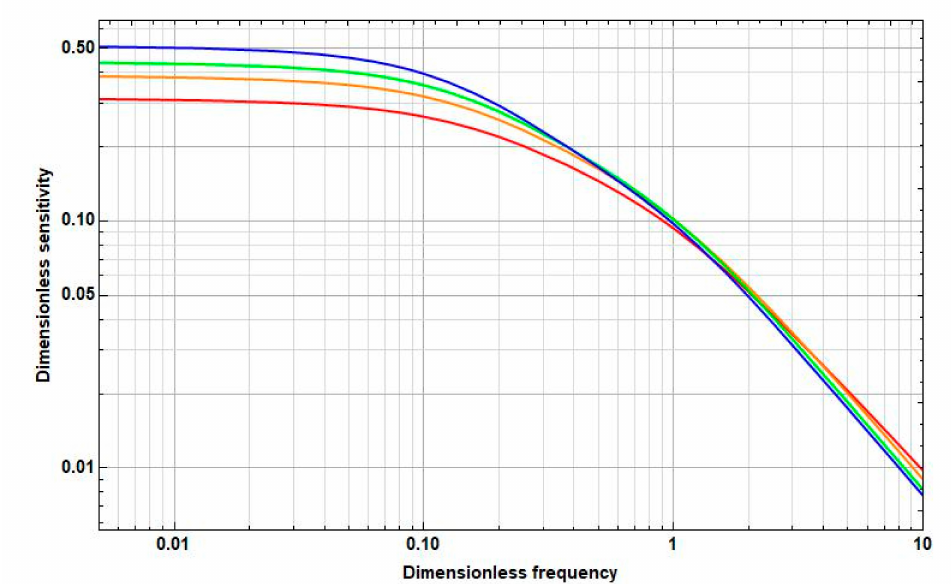
Figure 9. Frequency dependence of the sensitivity at di ff erent distances between the cathodes (red line, 2˜ l c = 0; orange line,